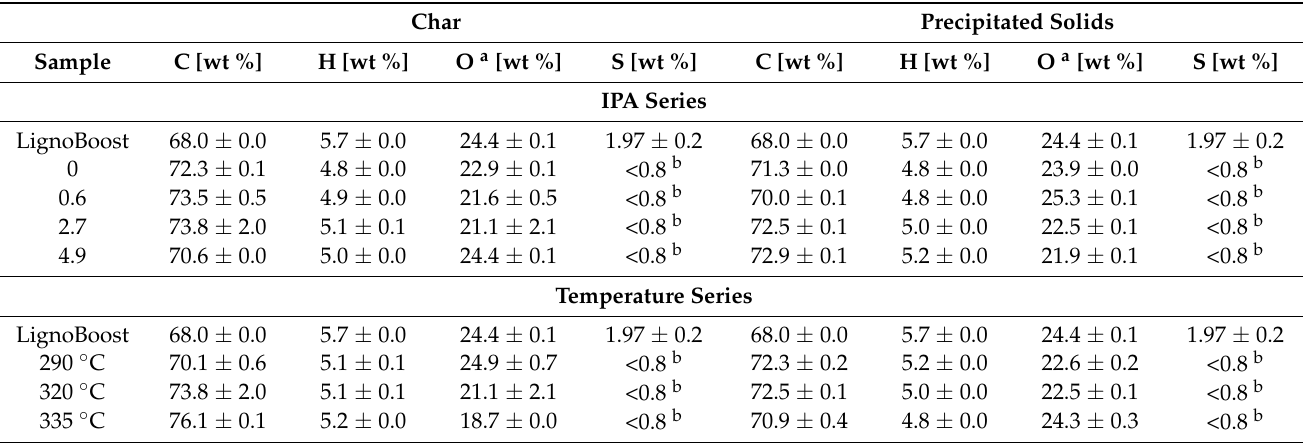
Table 2. Elemental composition, with standard deviations, of the solids and LignoBoost lignin. Char